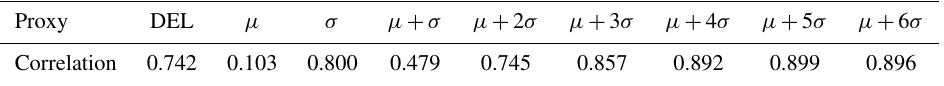
Table 1. Correlations observed between high-fidelity DEL and different loading proxies of the low-fidelity model using 100 heuristic sam- ples. Proxy